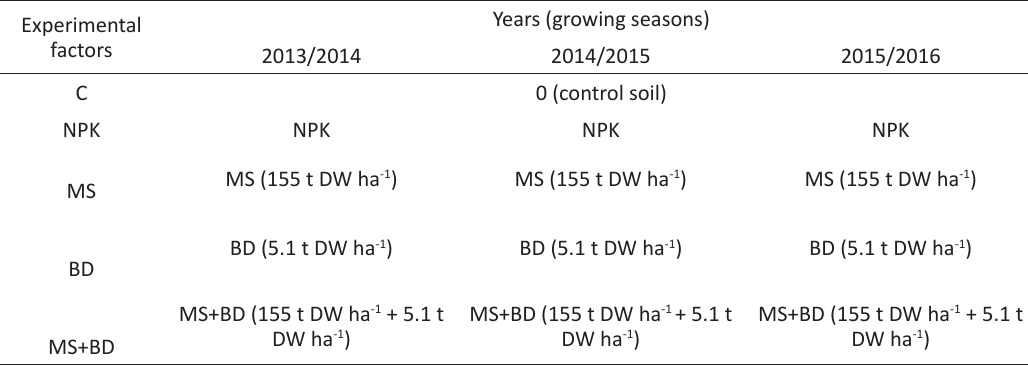
Table 2. Experimental design Experimental